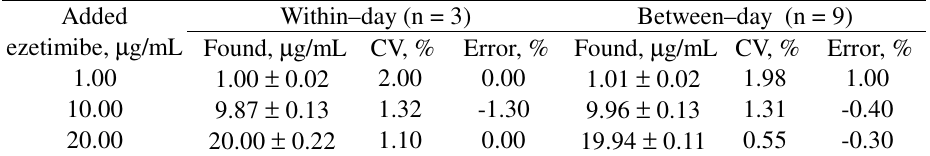
Table 2. Accuracy and precision data of determination of ezetimibe (1-20 µ g/mL) in the presence of simvastatin (20 µ g/mL) by first order derivative spectrophotometry